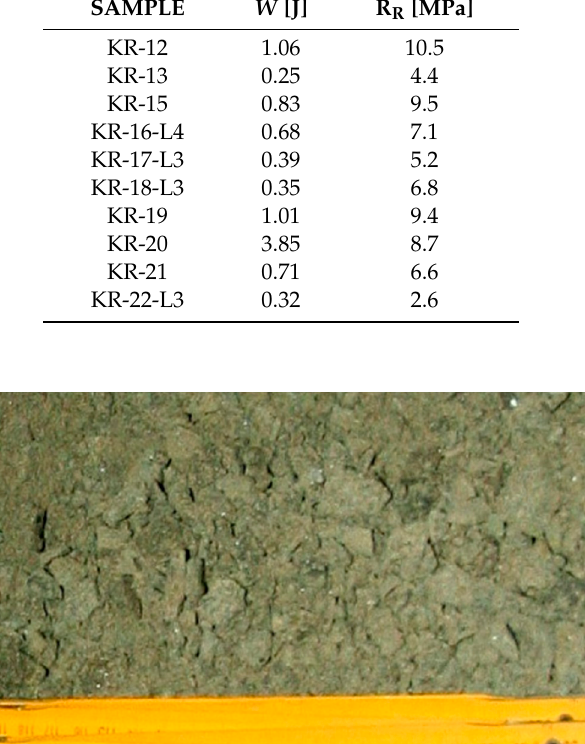
Table 2. Results for work done in Brazilian tests and tensile strength.